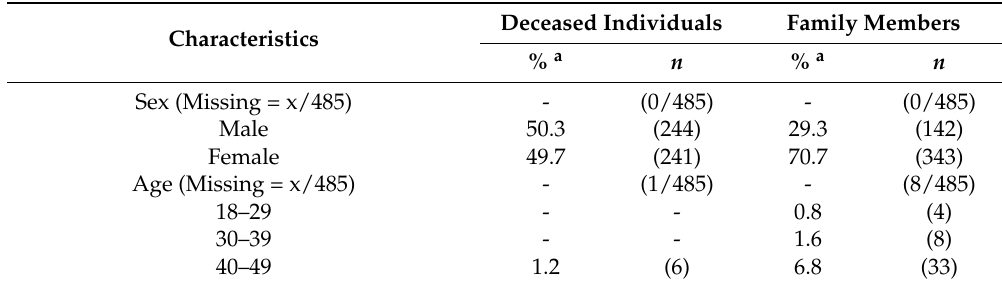
Table 1. Characteristics of deceased individuals and family